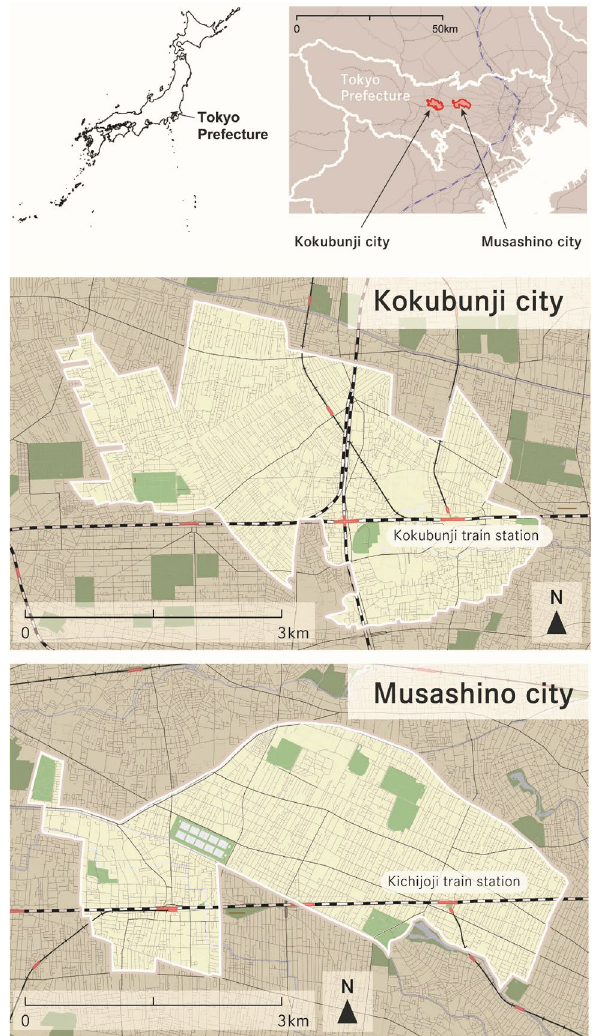
Figure 1. The locations of Musashino city and Kokubunji city in